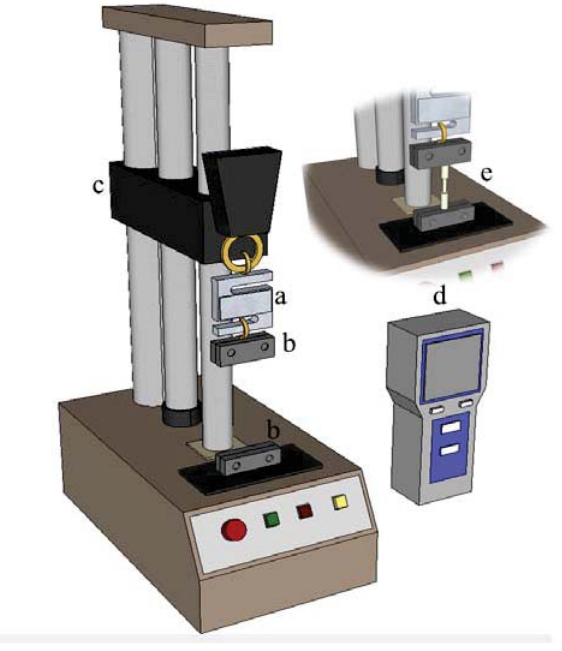
Figure 13. Schematic of the tensile test (Model FS-1002, Lutron Inc., New Taipei, Taiwan): ( a ) force gauge; ( b ) measuring fixture; ( c ) translation stage; ( d ) gauge value display; and ( e ) processed